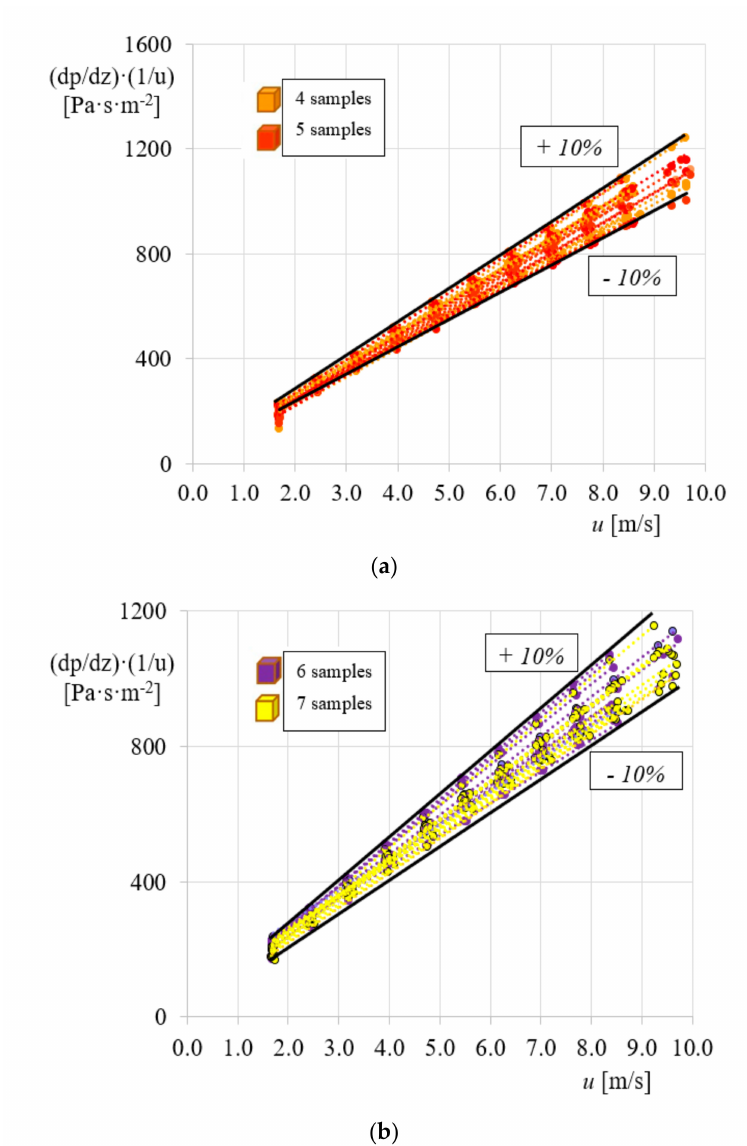
Figure 3. Pressure gradient (absolute value) scaled to the air velocity as a function of the frontal air velocity for: ( a ) assemblies with 4 ( H = 80 mm) or 5 ( H = 100 mm) AL-10-96 samples; ( b ) assemblies with 6 ( H = 120 mm) or 7 ( H = 140 mm) AL-10-96